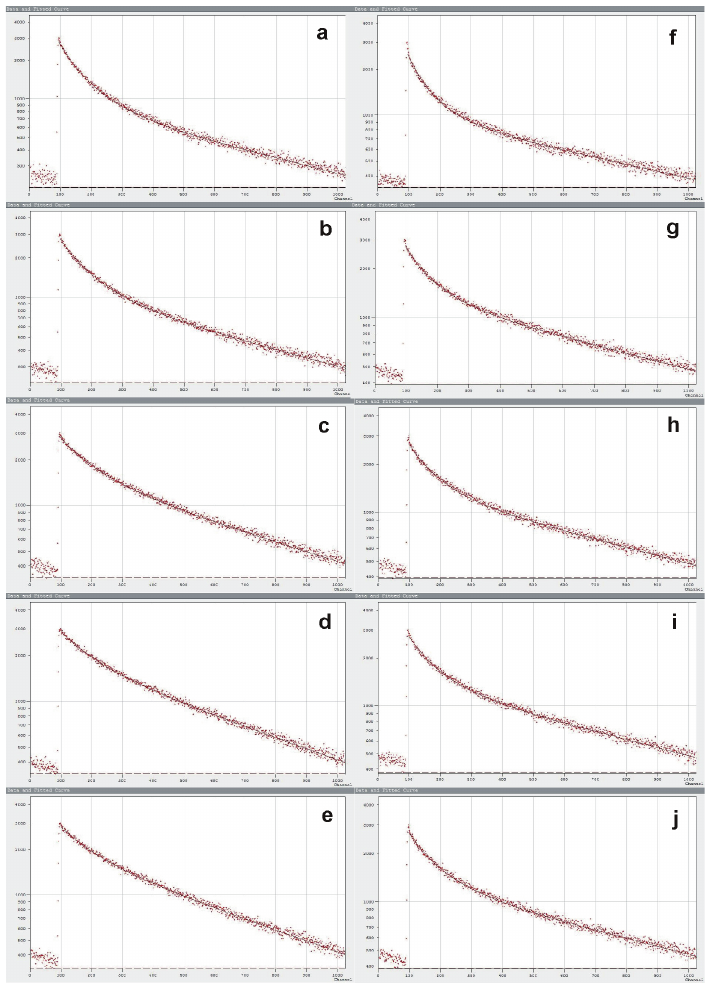
Figure 6: Fluorescence decay curves for DTAB concentrations 1.5 × CMC (a), 2 × CMC (b), 3 × CMC (c), 4 × CMC (d), 5 × CMC (e) and SDS concentrations 2 × CMC (f), 4 × CMC (g), 6 × CMC (h), 8 × CMC (i), 10 × CMC (j) The fitting curves are represented by solid